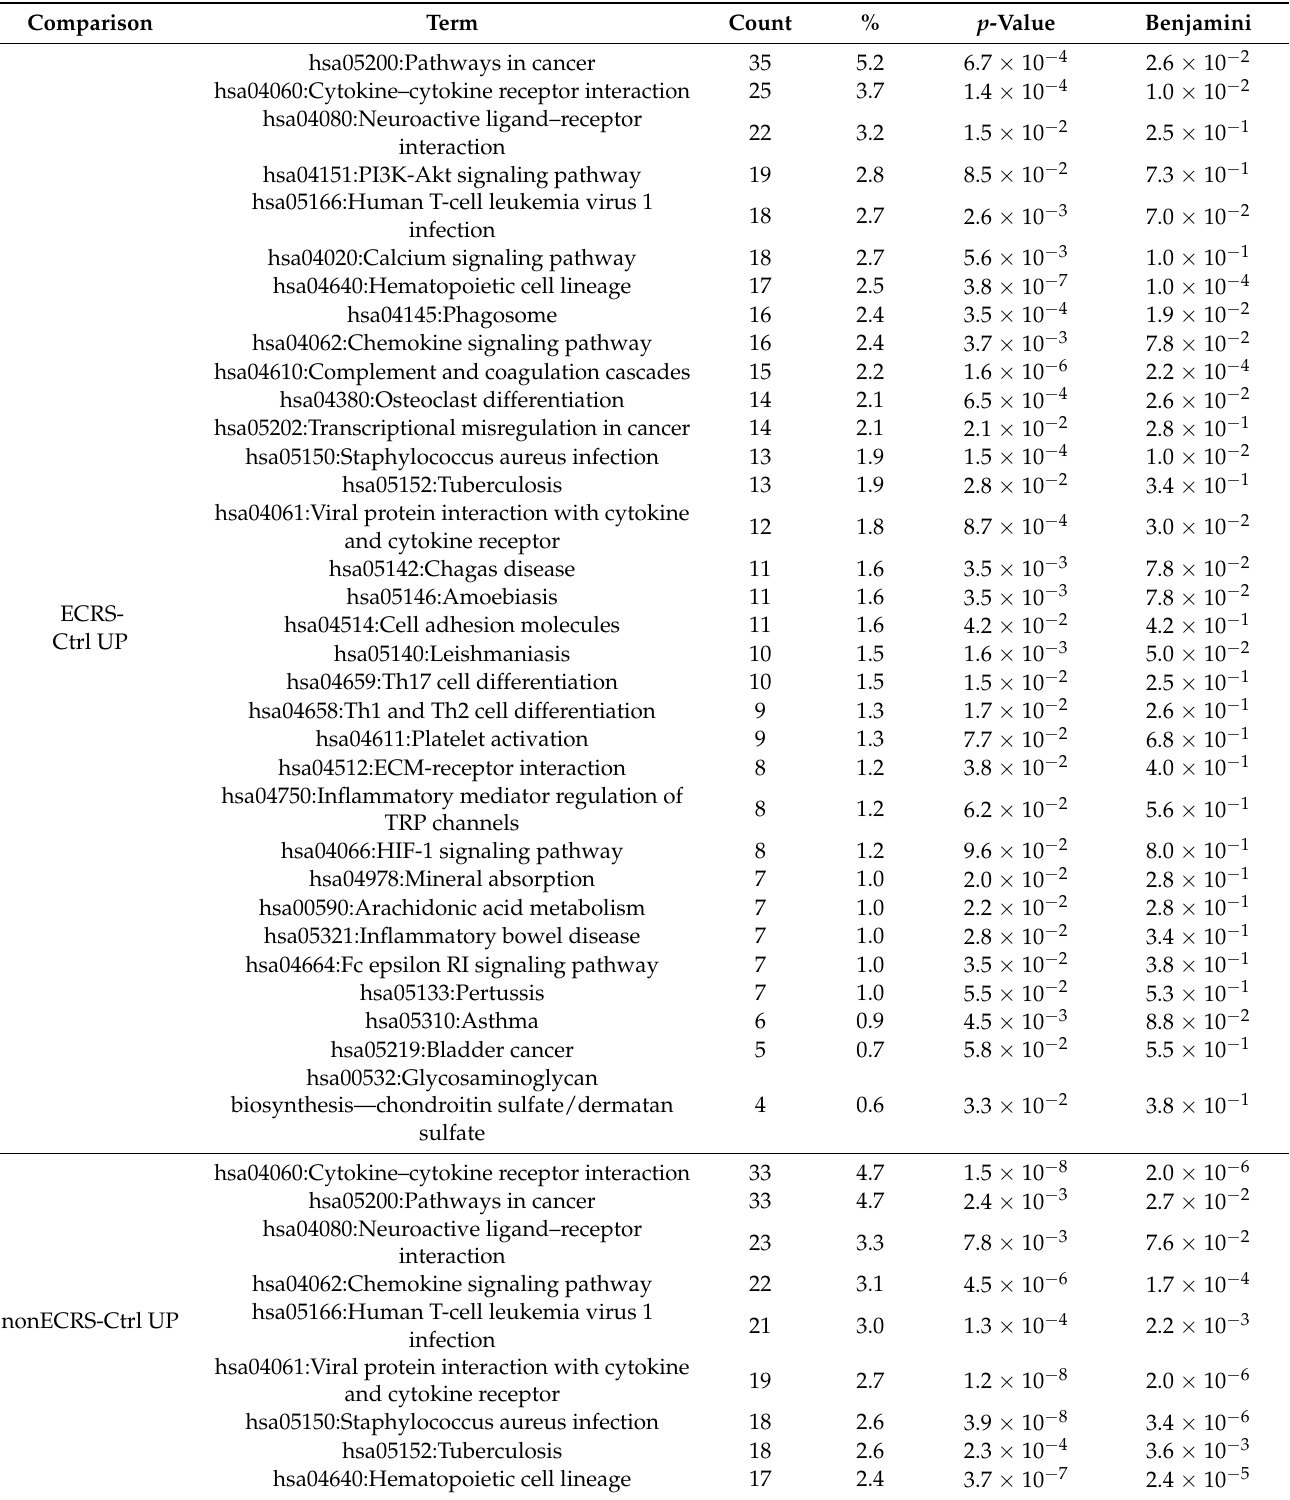
Table 1. KEGG pathways using the upregulated DEGs into DAVID. Genes with the disease-associated terms “cytokine–cytokine receptor interaction”, “hematopoietic cell lineage”, “chemokine signaling pathway”, “complement and coagulation cascade”, “osteoclast differentiation”, “Staphylococcus aureus infection”, and “viral protein interaction with cytokine and cytokine receptor” were commonly upregulated in all CRSwNP groups vs